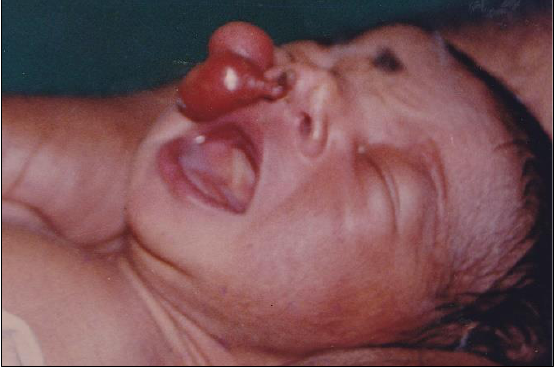
Figure 1: Clinical photograph showing the newborn with a bi- lobed mass hanging from the tip of the nose. The mass was soft with a few areas of firm consistency. There was no intranasal extension of the mass, with the normal nasal septum. Its surface was covered with wet mucosa. Its pedicle was 4 mm wide and 1 cm long. Upper lip, nasal tip, and ala, palate and face were otherwise unremarkable. Biochemical and hematological investigations including serum alpha-fetoprotein were within normal limits.